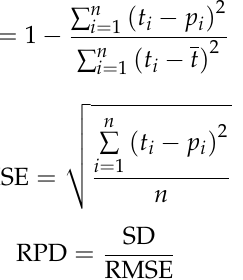
Table 1. Descriptive statistics of soil Hg, Cr and Cu.